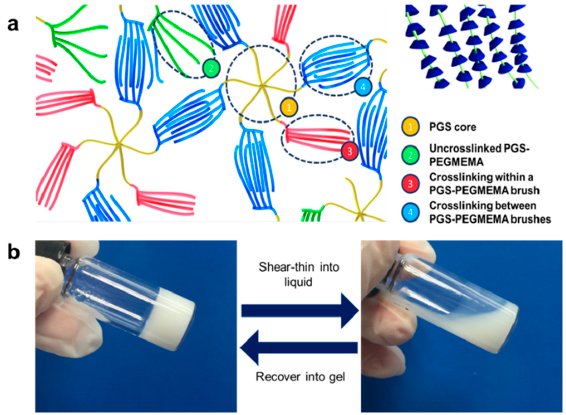
Figure 2. ( a ) Schematic showing the structure of the PGS-PEGMEMA/ α CD hydrogel. Each arm of the multi-armed PGS core (1) was polymerized with a “brush-structured” PEGMEMA. PEGMEMA was capable of forming inclusion complexes with α CD. The inset showed the threading of α CD onto each brush of PGS-PEGMEMA. These brushes with columns of stacked α CD formed polypseudorotaxanes which could crosslink to other polypseudorotaxanes to form intra- (3) or inter- (4) polymer hydrogen bonding by proximity. Some brushes may remain uncrosslinked (2); ( b ) Picture showing the shear-thinning of the PGS-PEGMEMA/ α CD hydrogel into a liquid. The gel set back into a gel if left to sit.